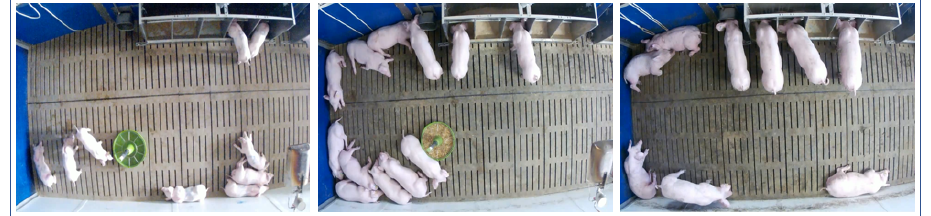
Figure 2. Example frames of the pig compartment under investigation with a known number of